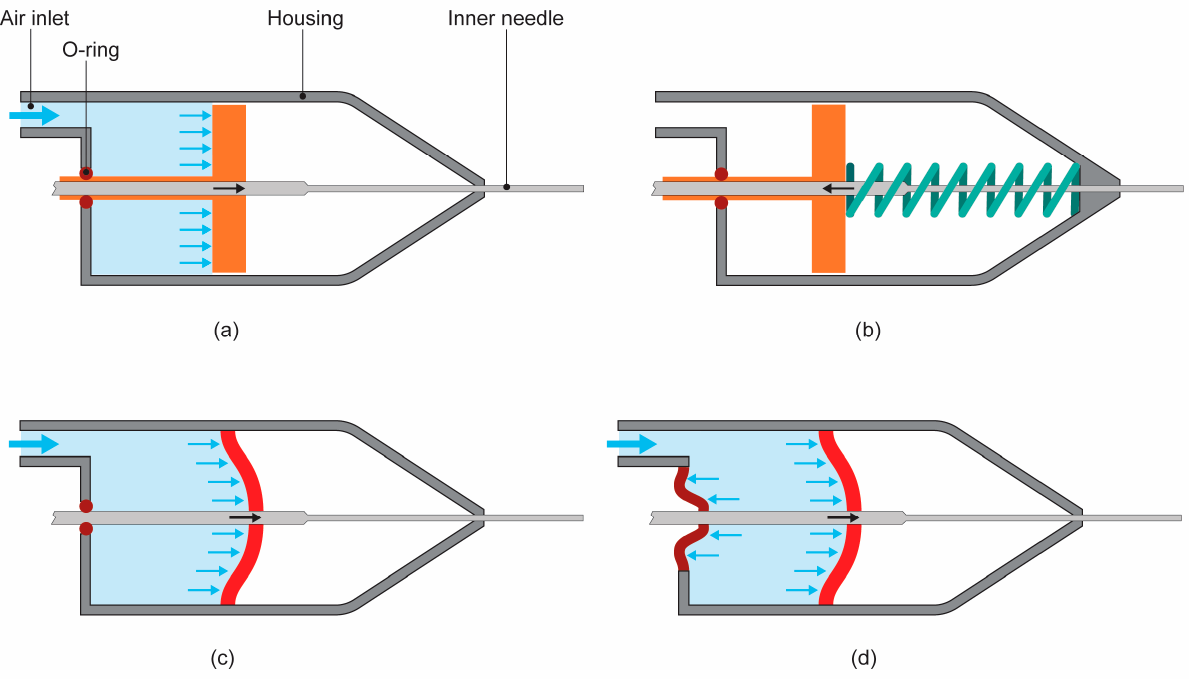
Figure 3. Evolution of the design for the non-assembly vitrectome driving mechanism. ( a ) Schematic design of a simple, pneumatically actuated driving system with a piston (orange) delivering a forward motion for the inner needle by means of air pressure. ( b ) Same design in which the backward force is delivered by a spring (green). ( c ) Piston–spring system replaced by a flexible diaphragm, which fulfills both the function of the piston and the spring. ( d ) Dual diaphragm system in which the back of the instrument is also sealed with a diaphragm.